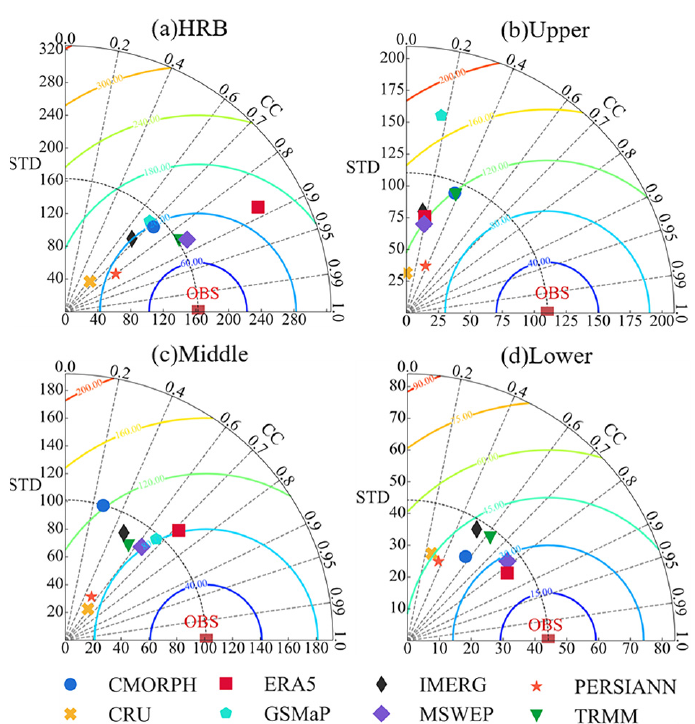
Figure 5. Taylor diagrams of annual precipitation estimates from each product in comparison with observations at stations over the ( a ) entire HRB and ( b ) upper, ( c ) middle and ( d ) lower reaches of the basin during 2016–2019.